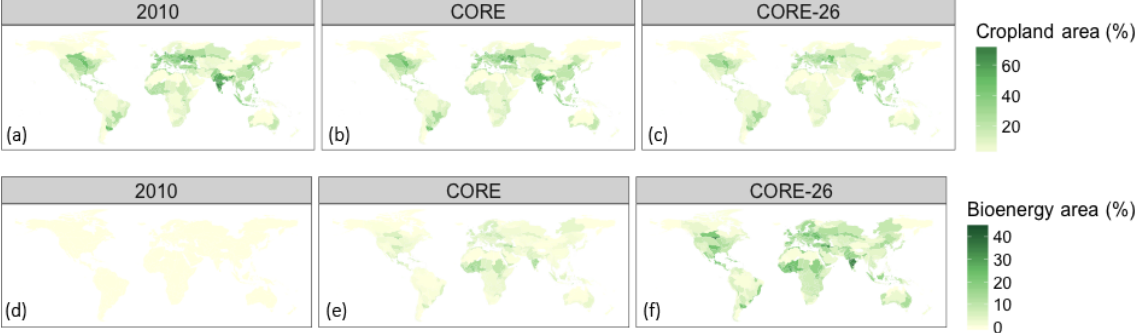
Figure 8. Percentage of regional land area devoted to cropland (a–c) and bioenergy (d–f) in 2010 (a, d) and 2100 in the CORE (b, e) and CORE-26 (c, f) scenarios. Note that there is no dedicated bioenergy cropland in 2010 in GCAM; hence, map (d) has zero values